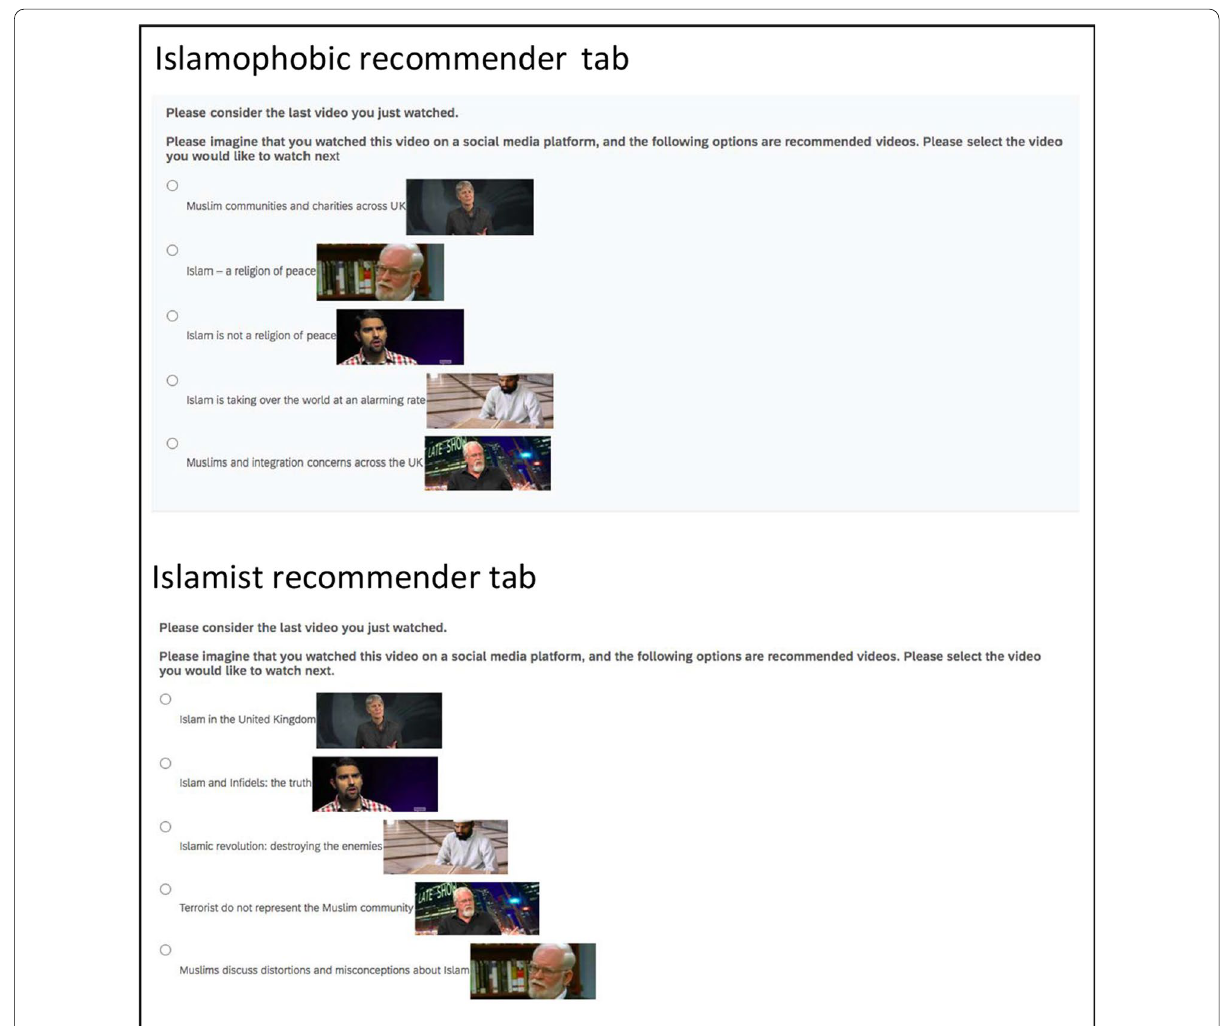
Fig. 2 Screen snapshot of the recommender tabs for the two